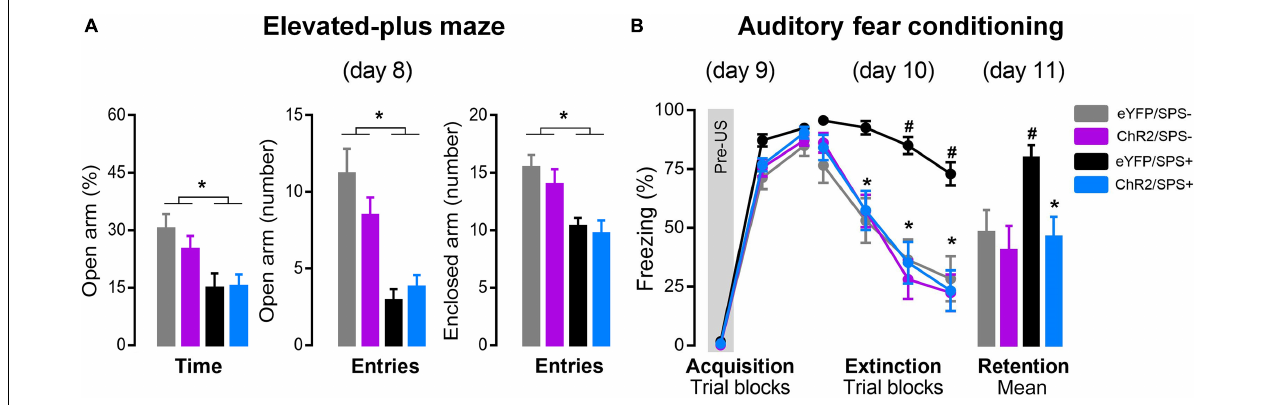
FIGURE 2 | The effects of left-IL optogenetic stimulation on anxiety and extinction of conditioned fear in SPS rats. (A) Effect of the SPS on anxiety-like behavior evaluated in the elevated plus-maze (day 8). Bars represent mean + SEM of the percentage of open arm time and the number of open and enclosed arm entries of eYFP/SPS − ( n = 10), ChR2/SPS- ( n = 10), eYFP/SPS+ ( n = 14) and ChR2/SPS+ ( n = 11) rats. * p < 0.05 vs. SPS- rats. (B) Optogenetic stimulation of left IL neurons enhance fear extinction of SPS+ rats. Acquisition (day 9): data are shown as mean ± SEM of the percentage of freezing in blocks of three trials (Pre-US is an average of the two pre-tones and the tone before the shock). Extinction: data are shown as mean ± SEM in blocks of five trials (Total of trials: 20 CS+). Retention: data are shown as mean + SEM of the average of five trials (5 CS+). Duncan’s post hoc : * p < 0.05 vs. first trial block (extinction) of each group or eYFP/SPS+